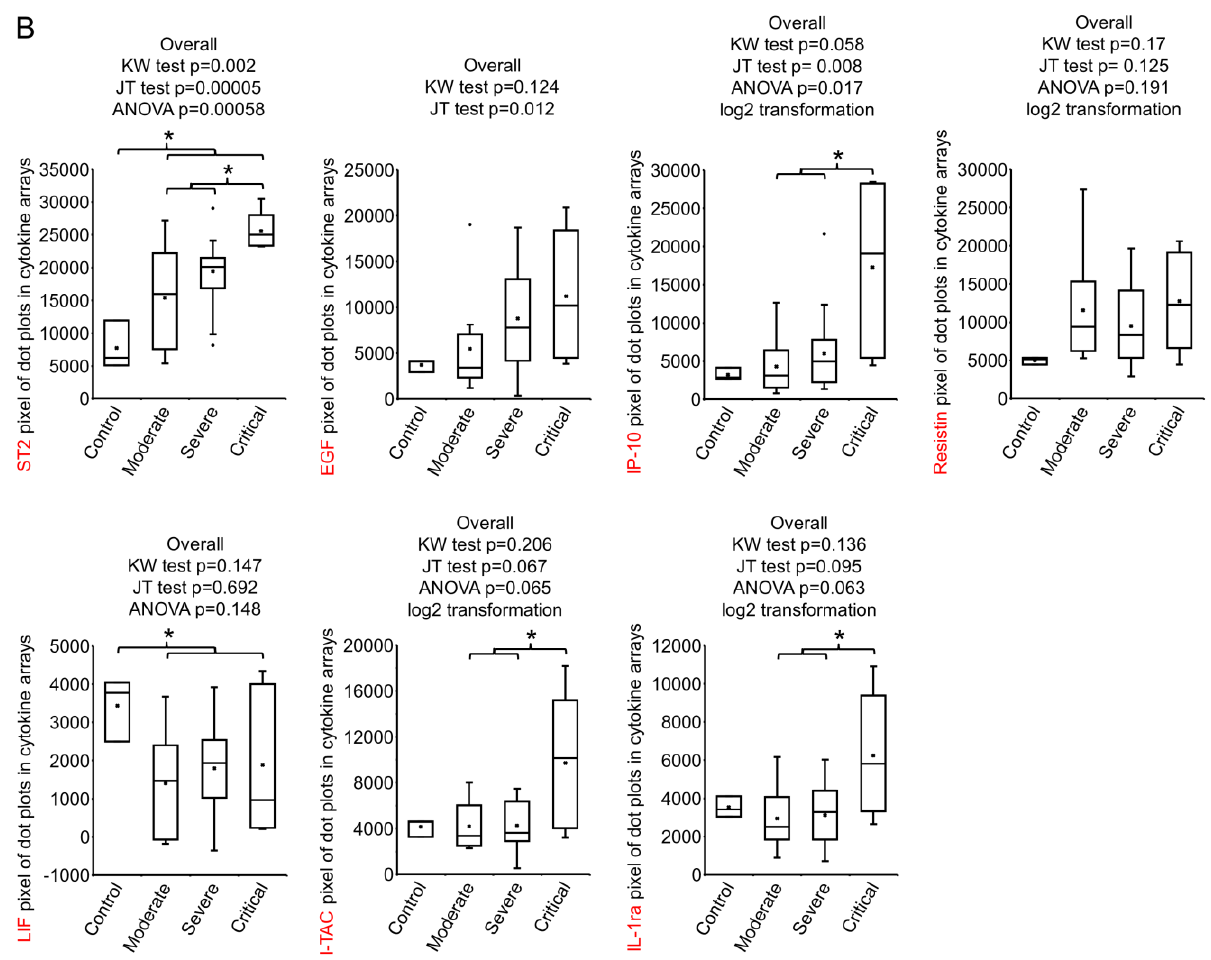
FIGURE 1: Screening of early plasma cytokines. (A) Human XL Cytokine Array Kits were used for cytokine screening. 20 μl plasma from each patient were diluted with 1.5 ml Array Buffer 6 and applied to one Cytokine Antibody Array Membrane. Blot images were quantified with Quick Spot image analysis software and normalization among batches of assays was done against positive controls. Shown is the expression heatmap of the cytokines. Cytokines were arranged according to the expression ratio of disease (moderate + severe + critical, n= 9 + 22 + 5 =36) to